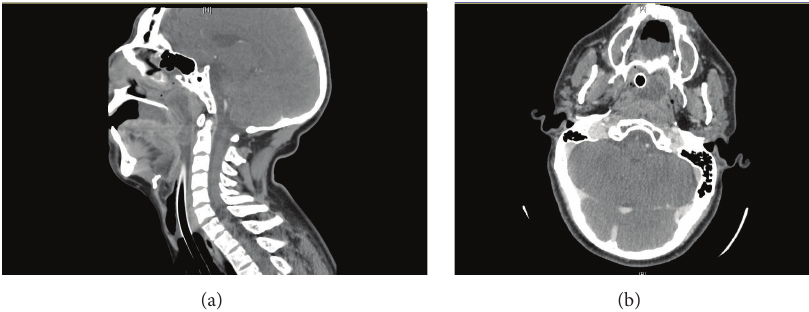
Figure 1: Sagittal (a) and axial (b) contrast enhanced CT images of soft tissue of the neck. Sagittal image shows isodense to hypodense central attenuation with a scattered rim of thin peripheral enhancement (a). The axial image shows the mass located in the right frontal sinus with near complete opacification of the anterior and middle ethmoid air cells and maxillary sinuses with thickening of the pharyngeal mucosa consistent with chronic pharyngitis and sinusitis.